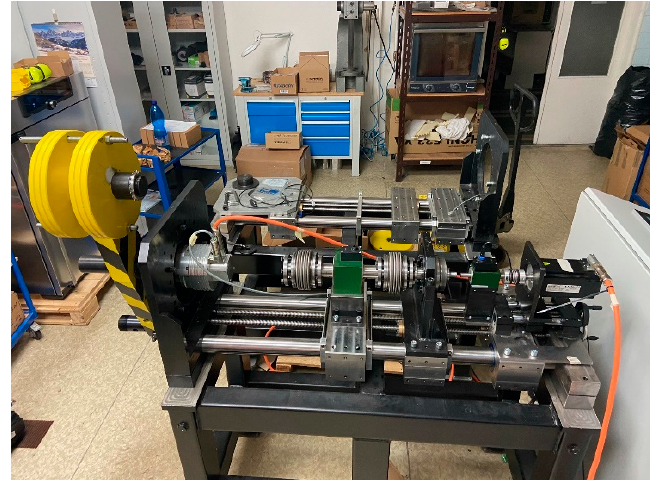
Figure 5. View of the stand in configuration A.